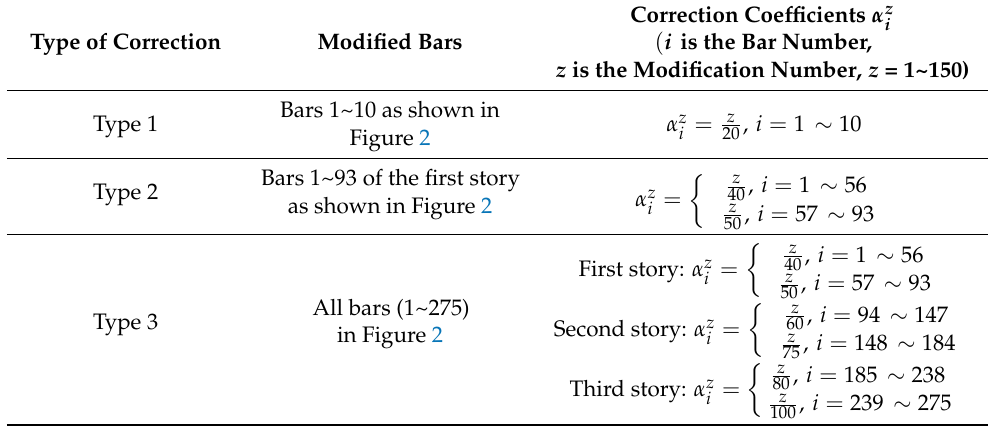
Table 4. Types of corrections in the 275-bar truss system.